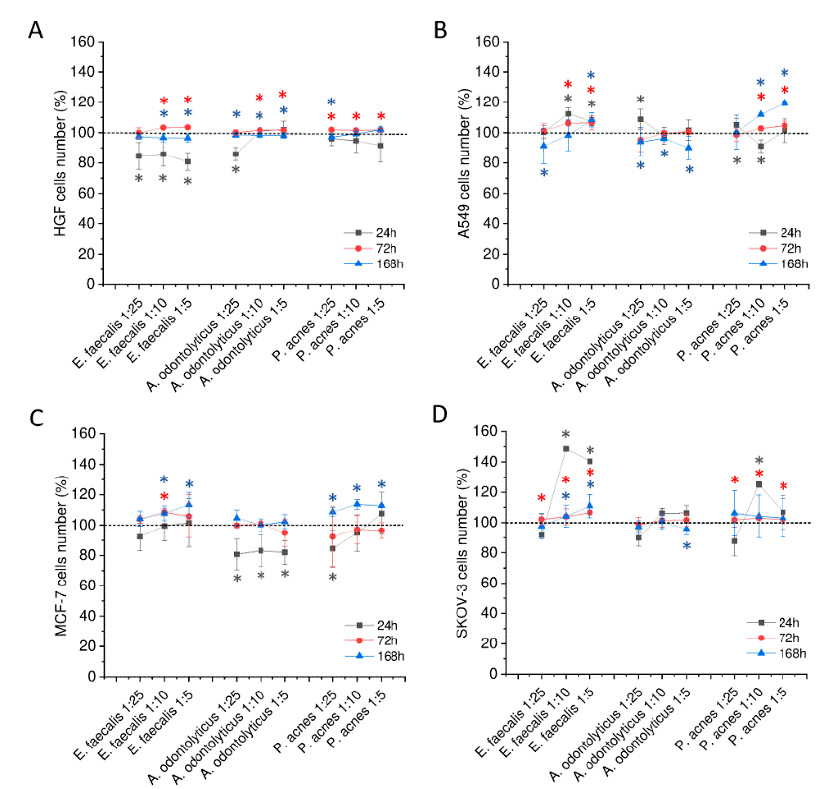
Figure 2. Alterations in doubling potential of gingival and cancer cells upon stimulation with biofilm-collected supernatants. Alterations in number of human primary gingival fibroblasts (HGF) (panel A ), lung carcinoma A549 (panel B ), breast cancer MCF-7 (panel C ), and ovarian carcinoma SKOV-3 (panel D ) cells upon stimulation with supernatants collected from biofilms of E. faecalis ATCC 29212, A. odontolyticus ATCC 17929, and P. acnes ATCC 11827 in dilutions ranging from 5 to 25. Results are presented as mean ± SD from 6 to 12 individual measurements. Dark grey, red, and blue asterisks indicate statistical significance ( p < 0.05) when comparing samples incubated for 24, 48, and 72 h, respectively, to unstimulated control cells. Horizontal short dashed line indicates the control, unstimulated cells (100%) to which all results were normalized.